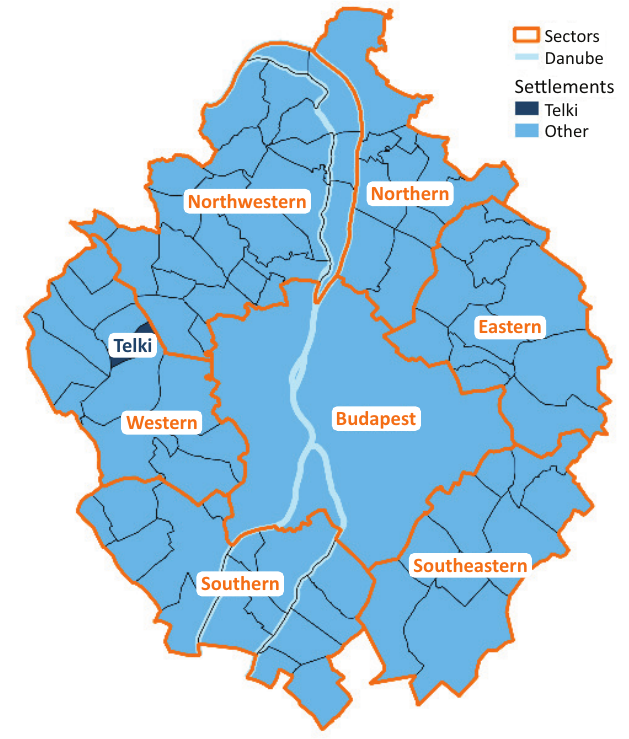
Figure 1. Sectors of agglomeration. Source: Compiled by Botond